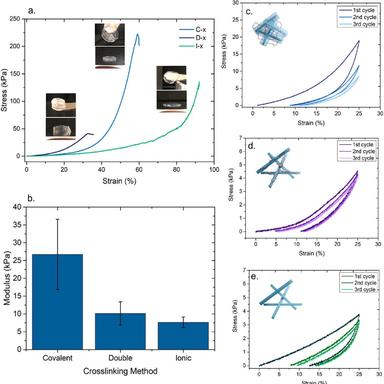
(a.) Compression loading profile and (b.) elastic modulus of the networks studied at an initial concentration of 1 wt% CNF. First 3 compressive cycles of (c.) Cx, (d.) D-x and (e.) I-x networks at a 25 % maximum strain.